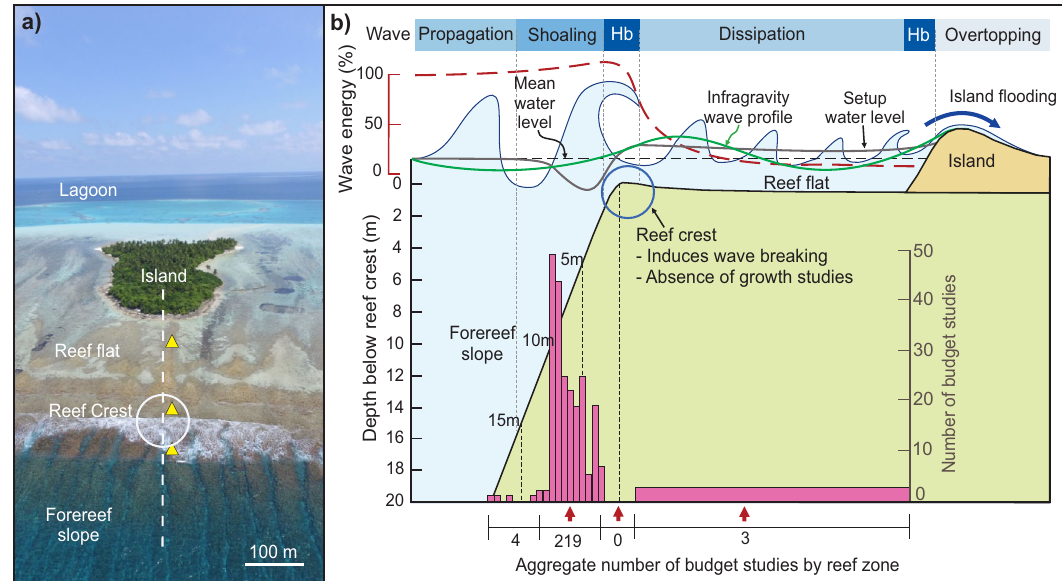
Fig. 1 Summary of wave interactions with Indo-Paci fi c coral reefs and reef fl ats. a Field location on the southwest rim of Huvadhoo atoll, Maldives, central Indian Ocean, showing primary geomorphic components of reef structure (also see Methods and Supplementary Fig. 1). Dashed line represents pro fi le presented in b . Yellow triangles show the location of wave gauges used to document cross-reef reduction in wave energy of 90% presented in Supplementary Fig. 2. b Summary of wave process interactions with a coral reef. The reef crest induces critical wave breaking (Hb) and cross-reef reduction in energy with subsequent cross-reef fl at wave transformations that can promote island fl ooding under higher wave energy conditions. Note the spatial distribution of contemporary carbonate budget studies by depth and the concentration of budget studies on forereefs at depths of 7 – 10 m which are used as proxies for potential vertical reef growth, and the paucity of reef growth estimates for the reef crest and reef fl at (data sources for budget studies presented in Supplementary Data